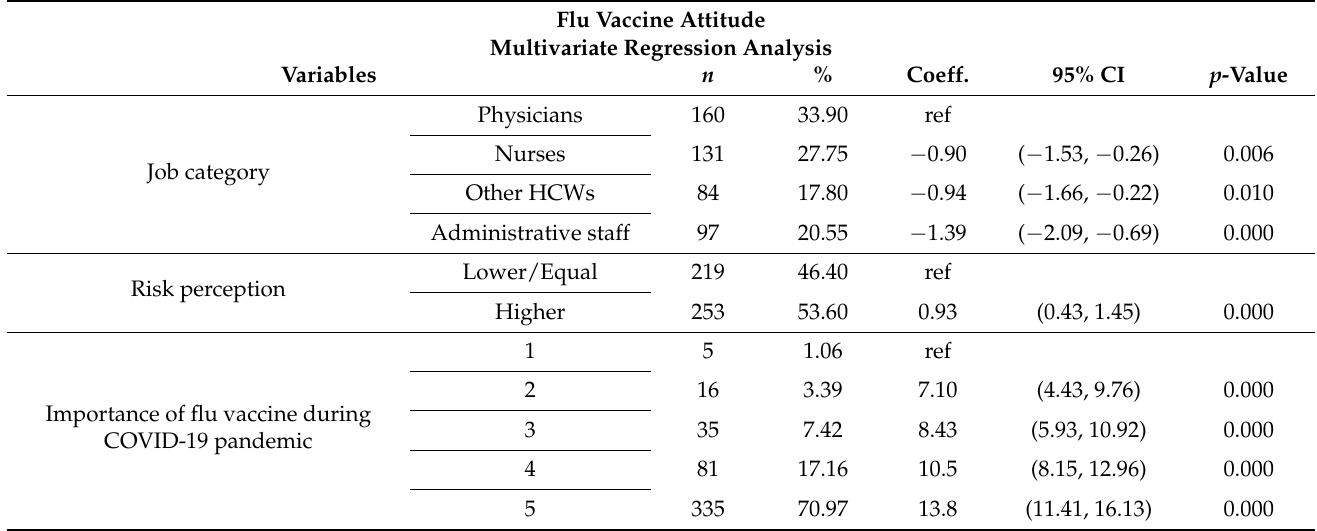
Table 4. Predictor variables of the Flu vaccine attitude in HCWs according to the multivariate regression